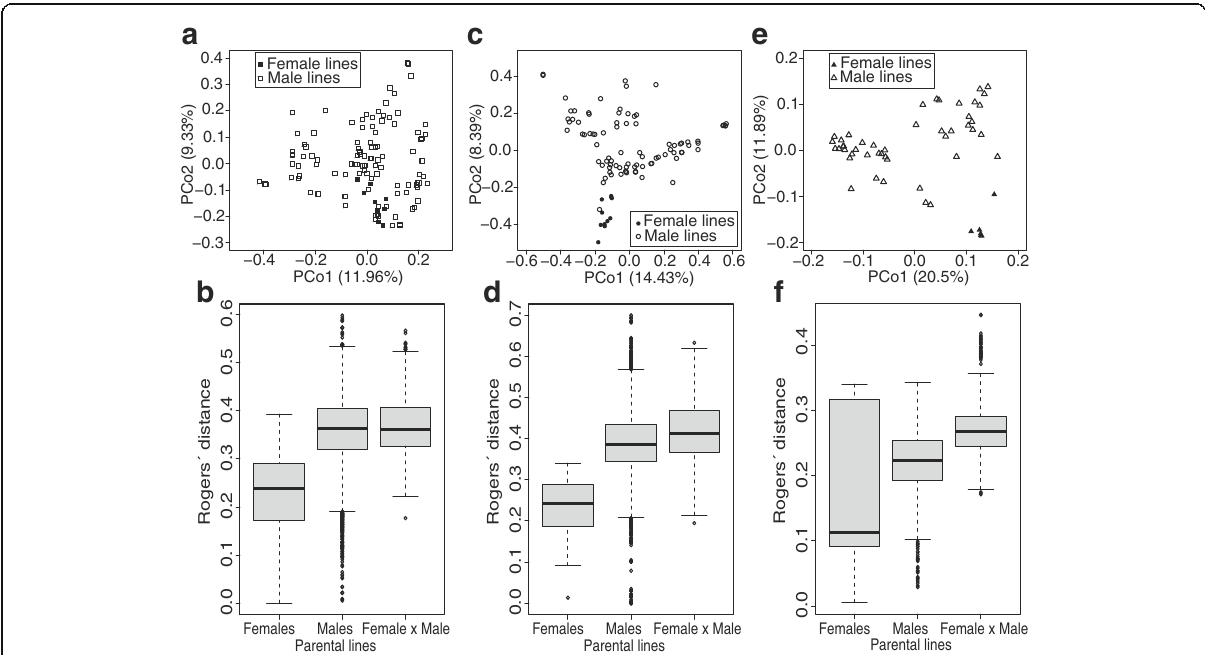
Fig. 2 Principal coordinate analyses of parental lines ( a ) for market segments LS, ( c ) MM, and ( e ) SS with relating distribution of Rogers ’ distances within and between parental pools ( b ) for market segments LS, ( d ) MM, and ( f ) SS